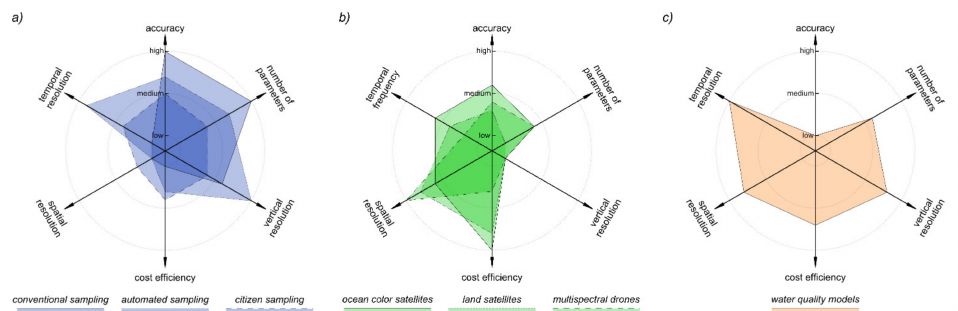
Figure 3. Schematic representation for the combination of ( a ) discrete, continuous, and citizen science measures combined with ( b ) remote sensing, and ( c ) modelling data. The combination provides complementary trade-offs of accuracy, number of parameters provided, spatial resolution, temporal frequency, and cost